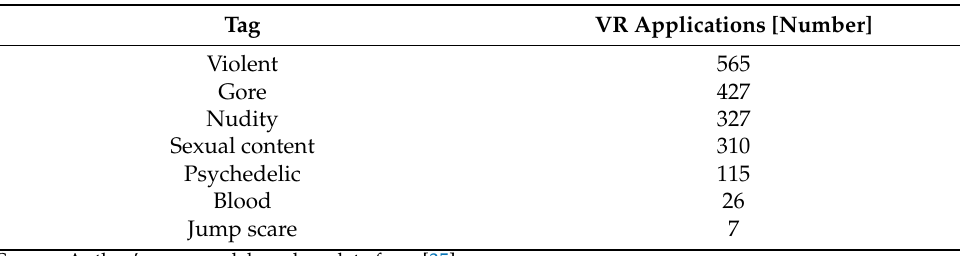
Table 5. The number of VR applications with tags unsuitable for some groups of people [state on 6 July 2022].